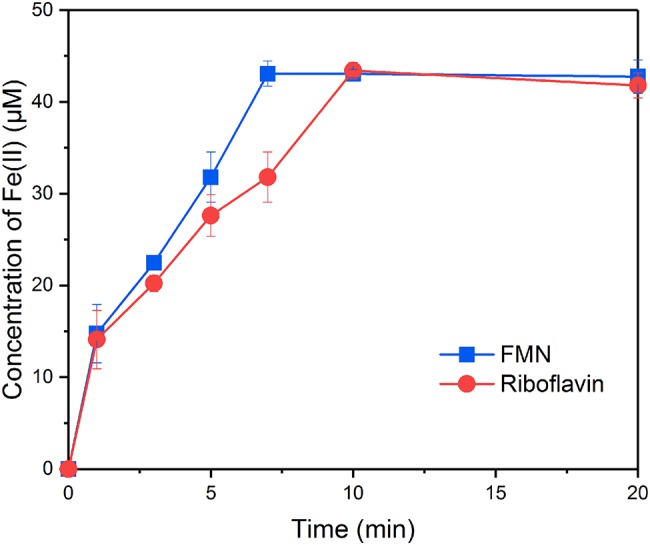
Reduction kinetics of goethite by FMNH2 and RFH2.